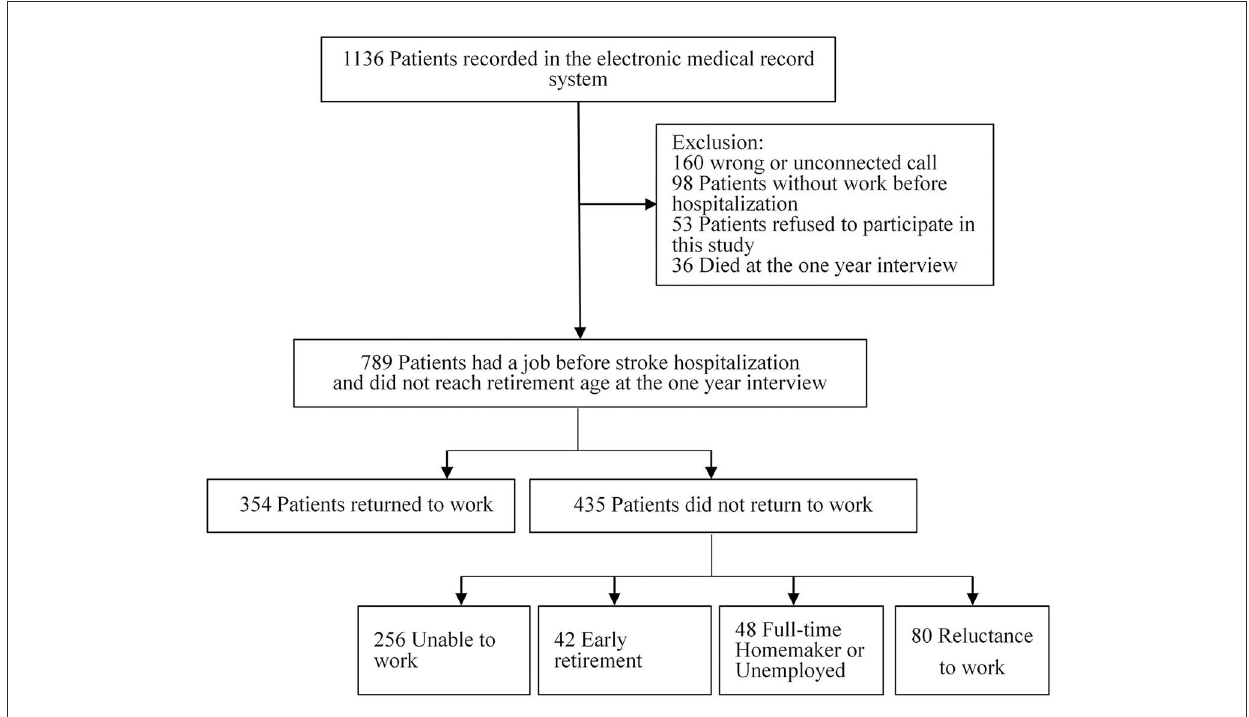
FIGURE1 Flowchart of patient